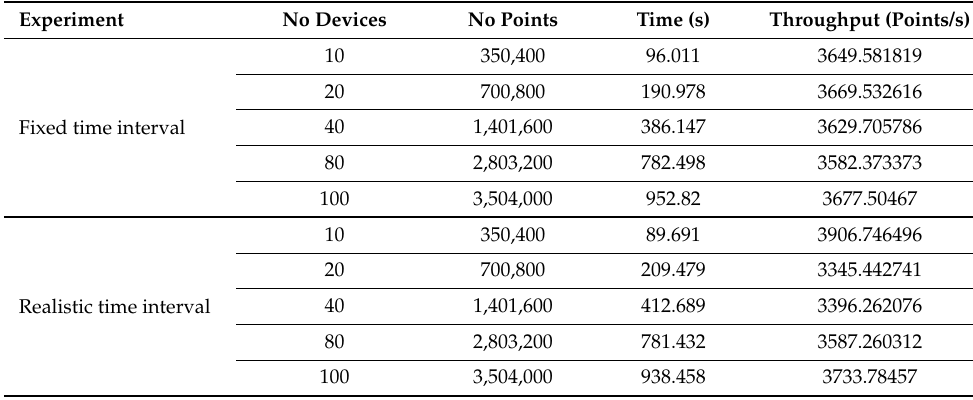
Table 3. Calculation of throughput. Batch size 3500.